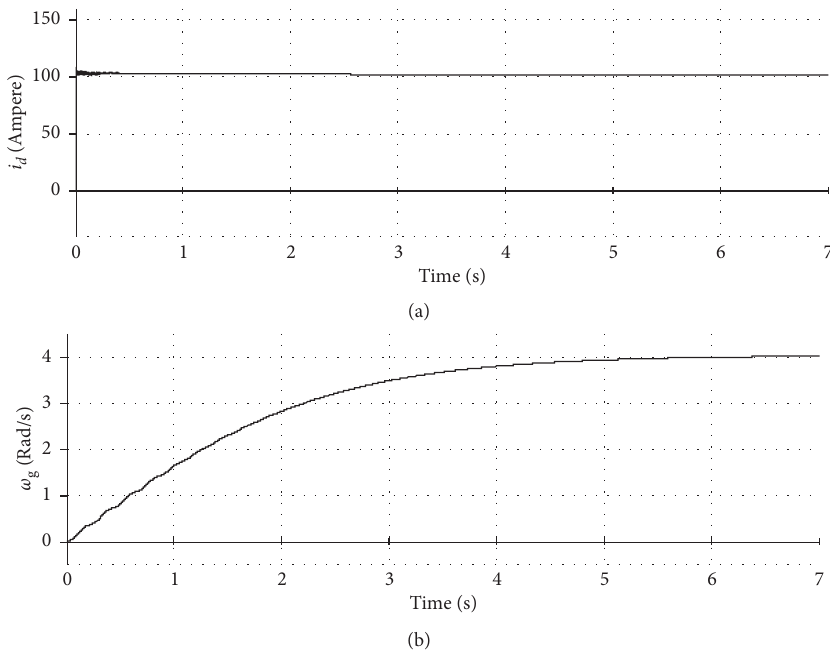
Figure 14: (a) Performance of the current on d -axis, i d (fast variable). (b) The angular velocity of the rotor, ω g